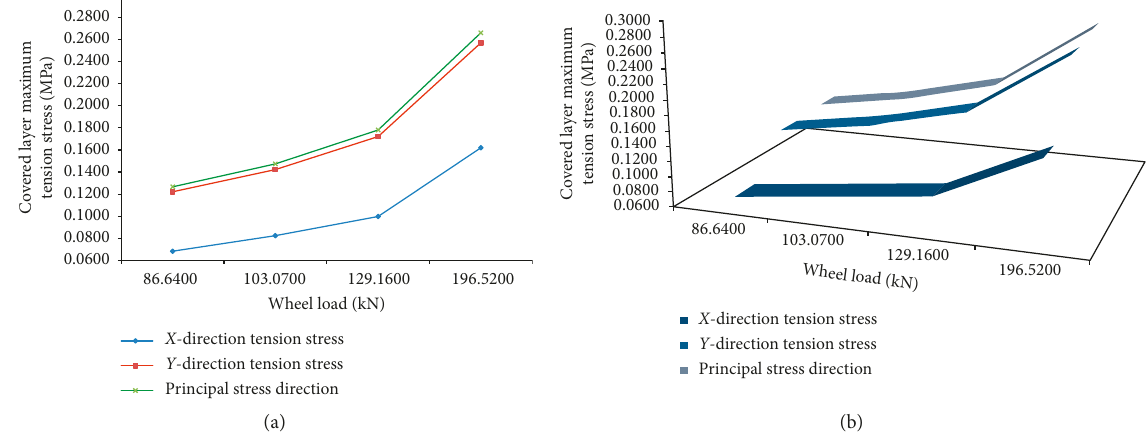
Figure 13: Variation of covered layer tension stress with the wheel load: (a) two-dimensional broken-line graph; (b) three-dimensional broken-line graph.